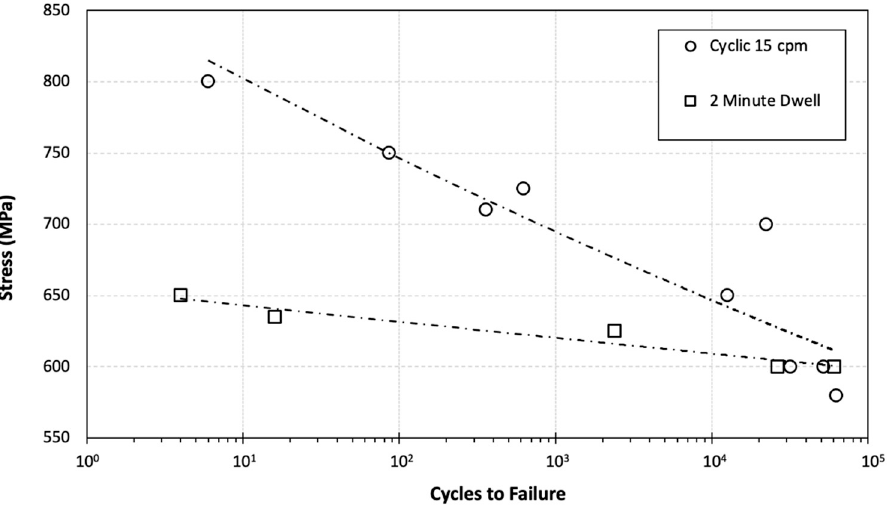
Figure 13. Load controlled fatigue data from cyclic and dwell testing.